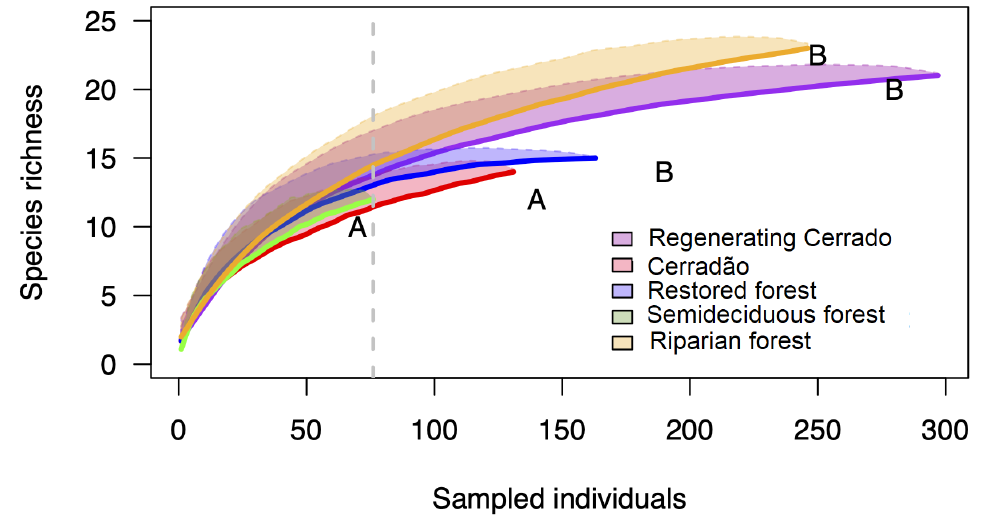
Fig 4 . Rarefaction curves based on sampling. The curves with different letters indicate significant differences.